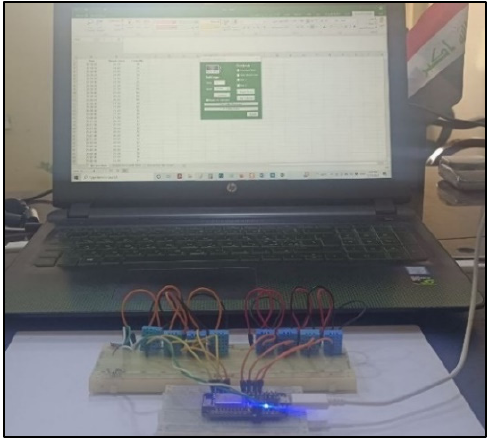
Figure 14. Eight sensor units testing and reading sample.